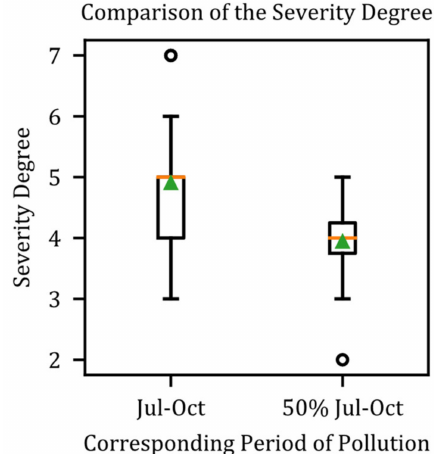
Figure 13. Comparison of the severity degree for two corresponding periods of pollution.